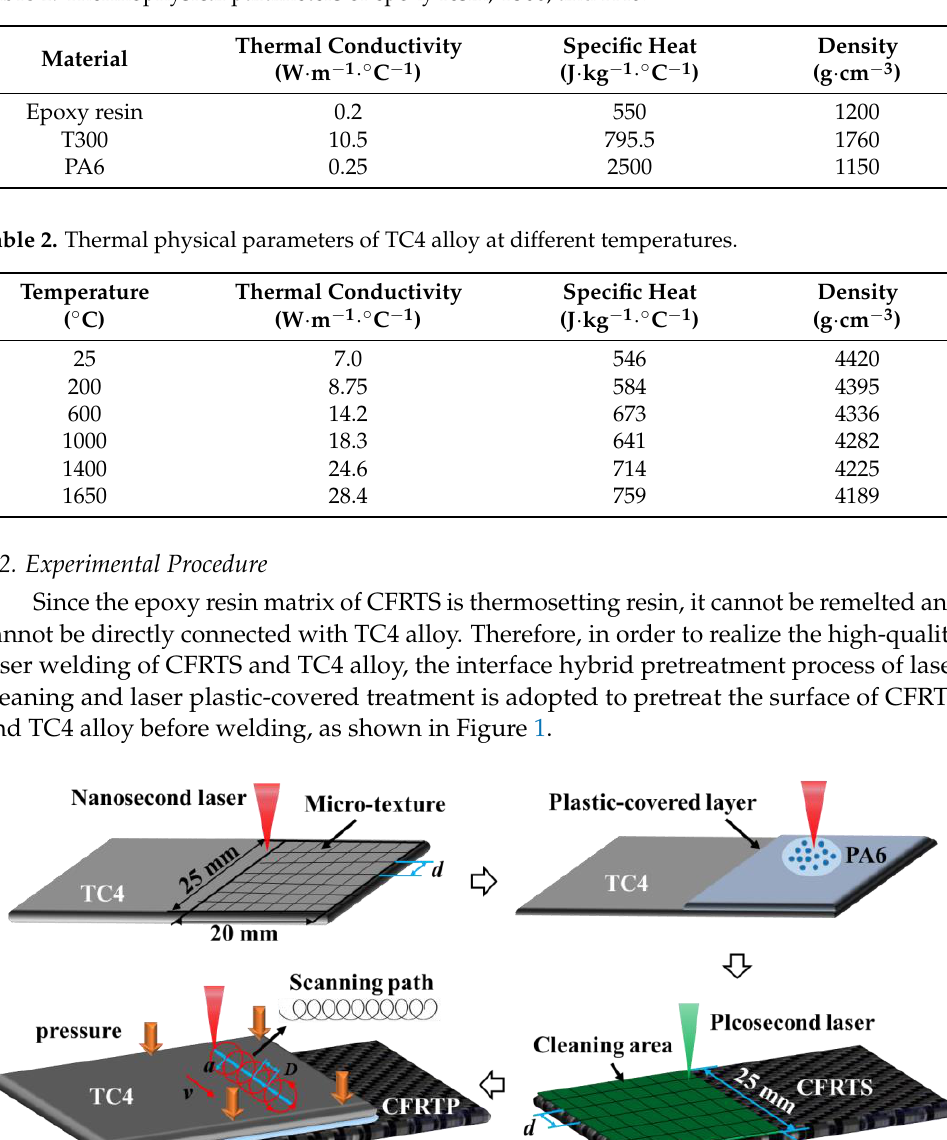
Table 1. Thermophysical parameters of epoxy resin, T300, and PA6.